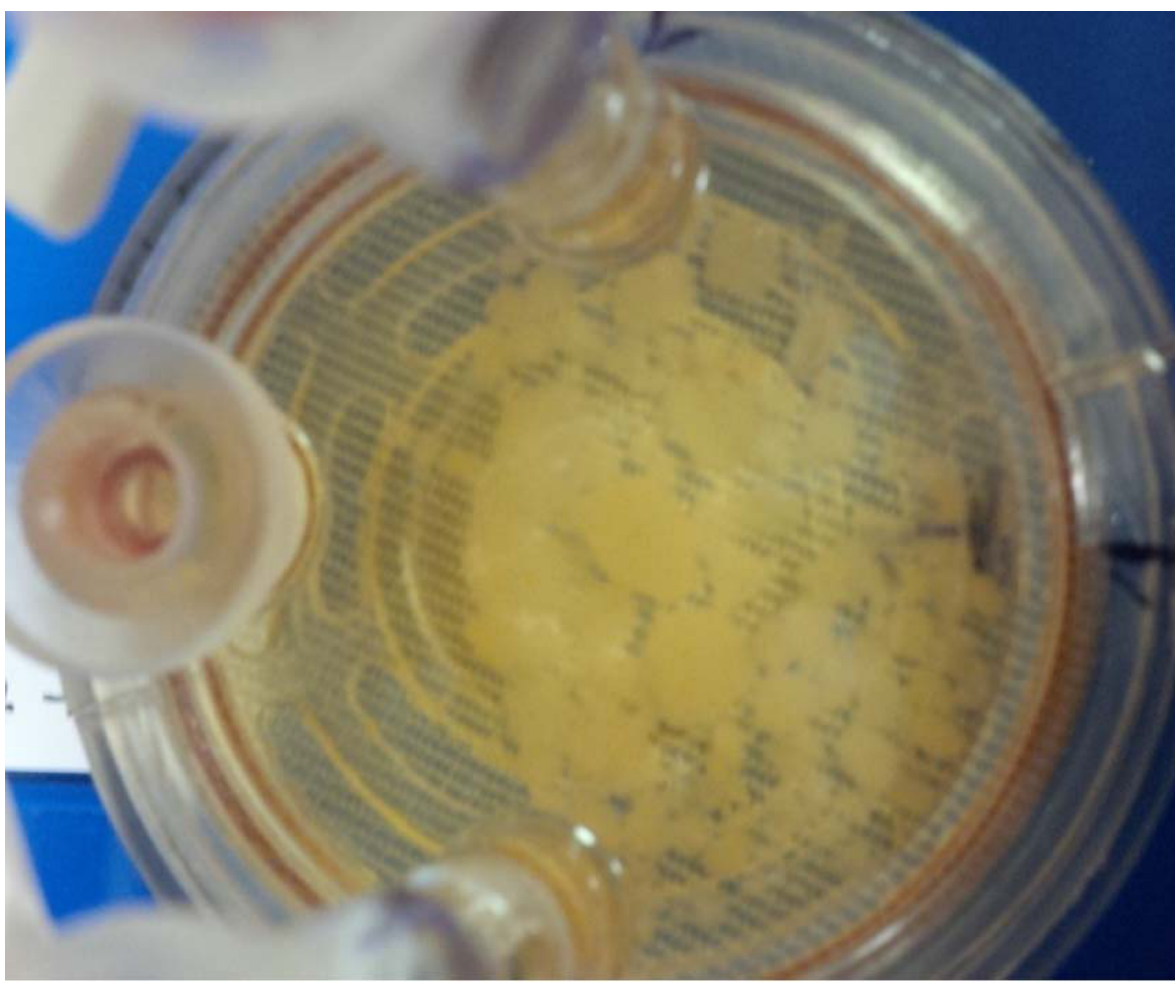
Figure 2. BmVIII ‐ SCC tick cell spheroids grown on macrogelatinous beads in a bioreactor. Day 90 p.i. View: 50X.